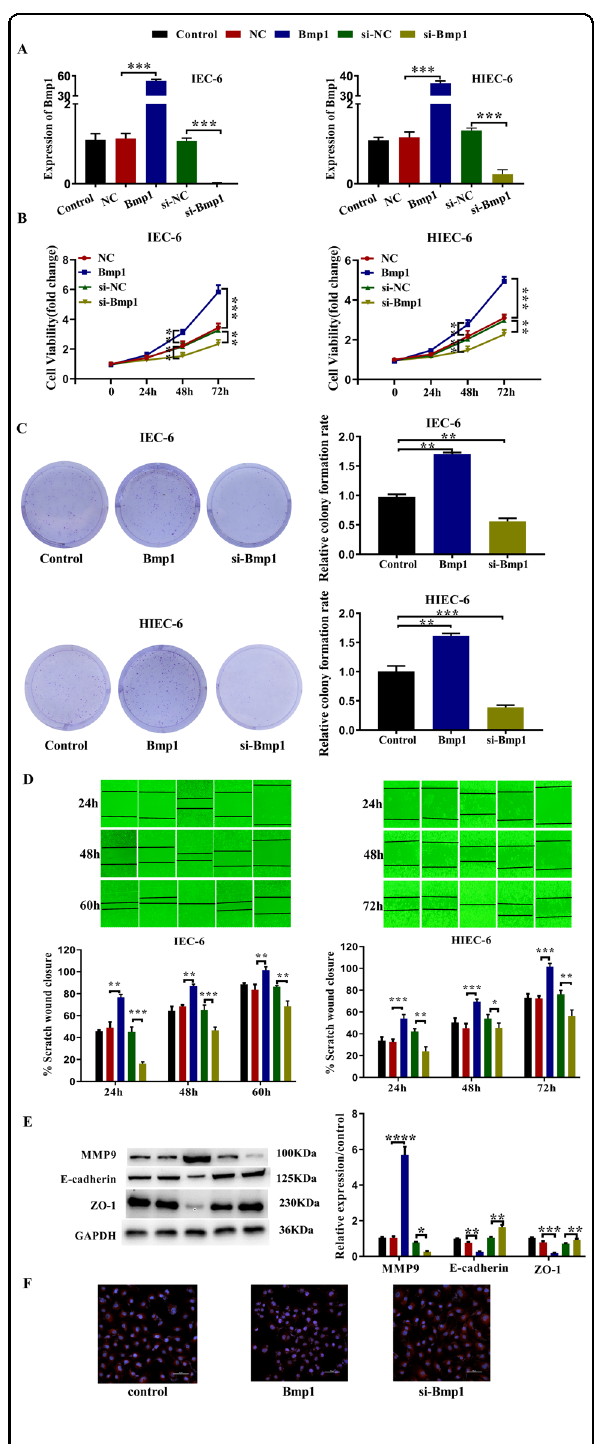
Fig. 2 Overexpression of Bmp1 promotes the migration and proliferation of IEC-6 cells. A The alter expression of Bmp1 was determined using qRT-PCR ( n = 3). B Cell viability ( n = 3), C colony formation assays were performed to exam the function of Bmp1 in cells proliferation. D Cell migration ability was quanti fi ed by the percentage of the area of cells migrated to the wound in the total wound area ( n = 3). E MMP9, E-cadherin, and ZO-1 were detected by western blot ( n = 3). F Representative immuno fl uorescence analysis showed the content of E-cadherin in treated IEC-6 cells ( n = 3). All data were demonstrated as mean ± SD from three independent experiments performed in duplicate. * p < 0.05, ** p < 0.01, *** p < 0.001, and **** p < 0.0001 were all signi fi cant